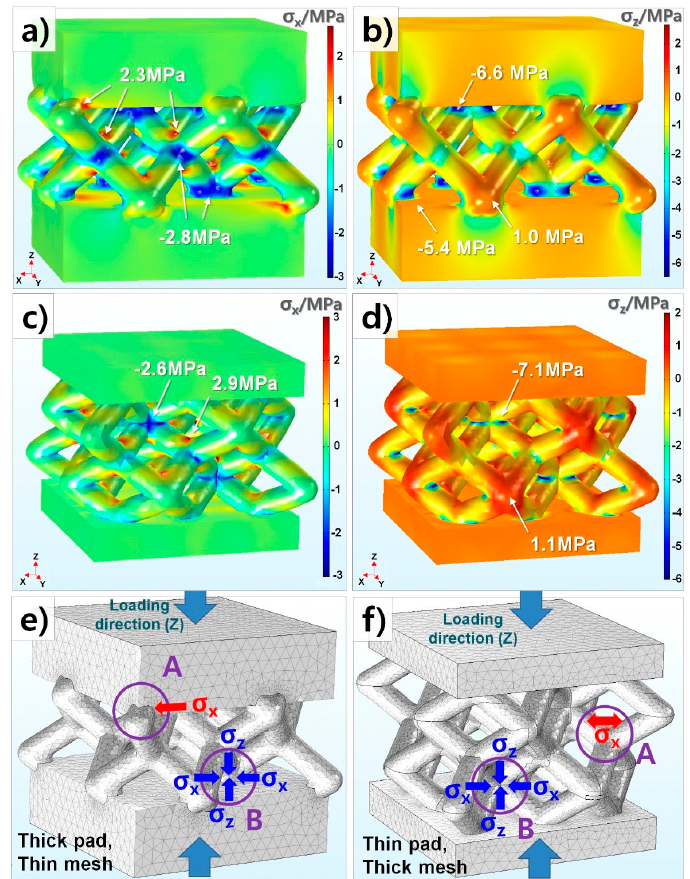
Figure 5. Mechanical stress analysis of lightweight designs with 15T-6 mm and 8T-10 mm (pad thickness and mesh beam width). ( a ) σ x distribution (x-direction stress) of 15T-6 mm ( b ) σ z distribution (z-direction stress) of 15T-6 mm ( c ) σ x distribution of 8T-10 mm ( d ) σ z distribution of 8T-10 mm ( e ) Stress concentration of 15T-6 mm ( t pad > t mesh ), A and B: Tensile and compressive stress at the interface of the mesh and pads, respectively ( f ) Stress concentration of 8T-10 mm ( t pad < t mesh ), A and B: Tensile and compressive stresses at internal mesh structure, respectively.